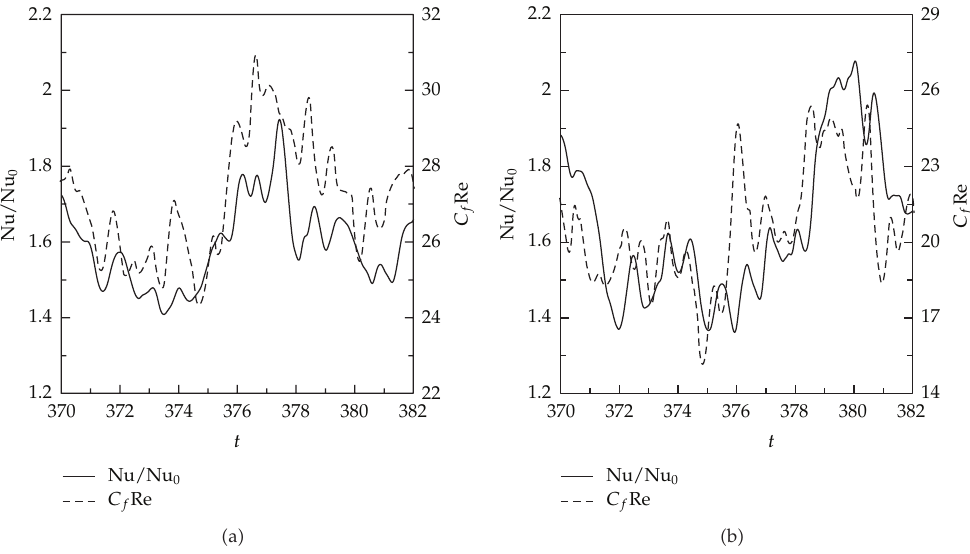
Figure 6: Time variation of normalized Nusselt number (cid:2) Nu/Nu 0 (cid:3) and skin friction coe ffi cient scaled with Reynolds number (cid:2) C f × Re (cid:3) on one of the (cid:2) a (cid:3) sidewalls (cid:2) b (cid:3) bottom ribbed walls at an arbitrary time